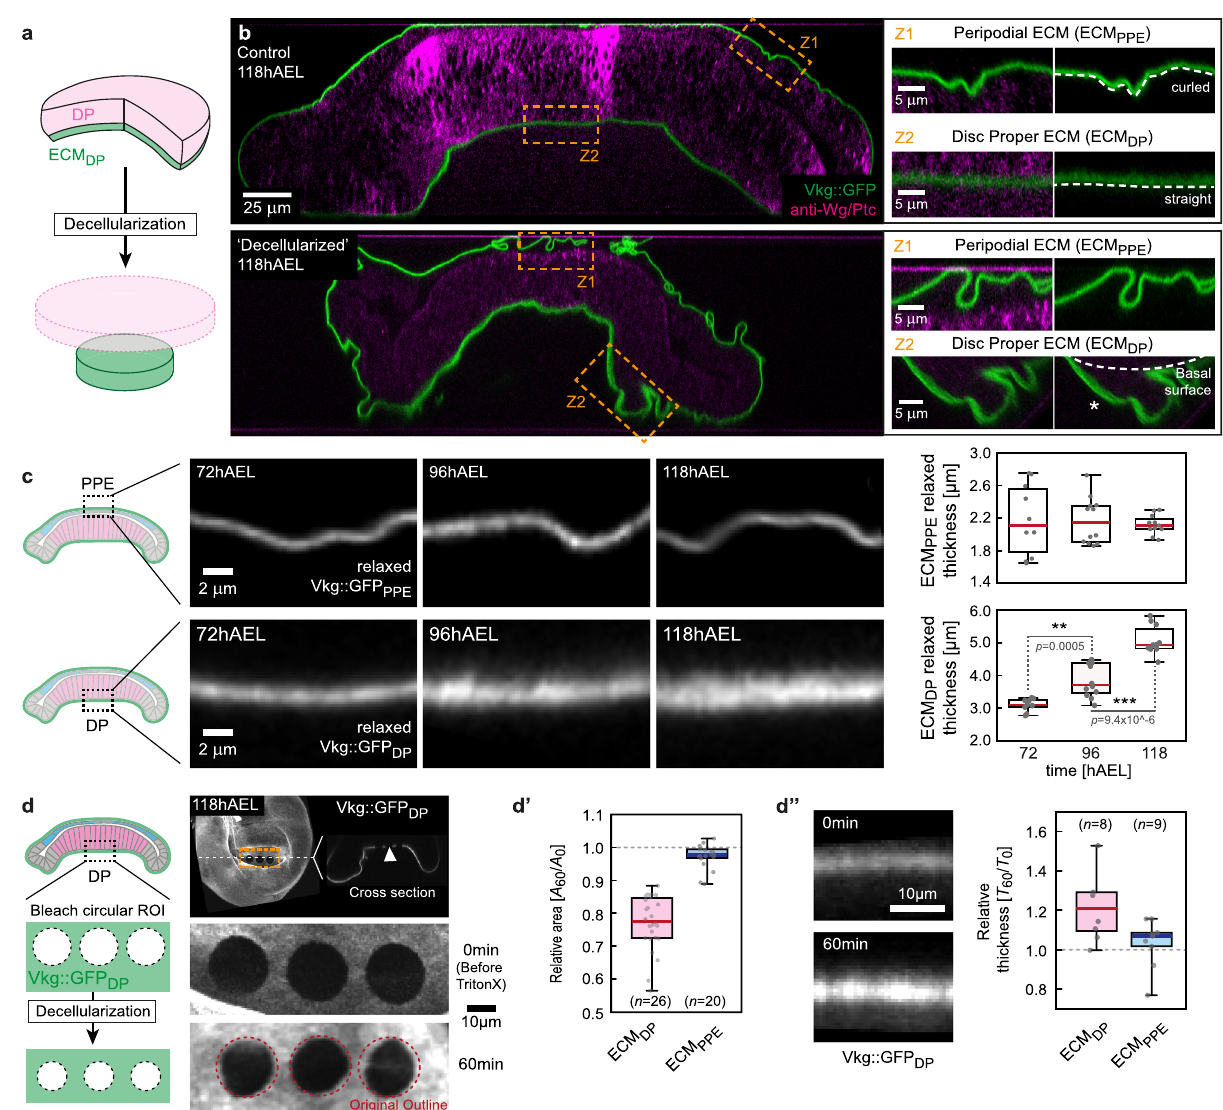
Fig. 4 | Spatial differences in ECM growth anisotropy amplify stress accumu- lation and allow symmetry breaking. a Acute removal of cellular pressure by decellularizationrevealstherelaxedcon fi gurationoftheECM. b Cross-sectionsofa control wing disc (top) and a wing disc after decellularization (bottom, see 'Methods'). The ECM is marked by Vkg::GFP (green) and the epithelial layers by a staining for Wg/Ptc (magenta). Right: magni fi cations of indicated regions. The relaxedgeometryoftheECMwasassessedinregionswheretheECMhadseparated from the epithelial layer (see asterisk). c Cross-sections of relaxed sections of the top ECM PPE (marked by Vkg::GFP PPE , top) and the bottom ECM DP (Vkg::GFP DP , bottom) at indicated stages. Right: quanti fi cation of relaxed ECM thickness (see 'Methods' for details, n indicates number of discs, for ECM PPE : n 72 =10, n 96 =12, n 118 =11, for ECM DP : n 72 =9, n 96 =12, n 118 =10). Statistical signi fi cance was assessed by a two-sided Student ’ s t test (unequal variance, * P ≤ 0.05, ** P ≤ 0.005, *** P ≤ 0.0005). d Left: scheme showing how circular regions of interest (ROI) were